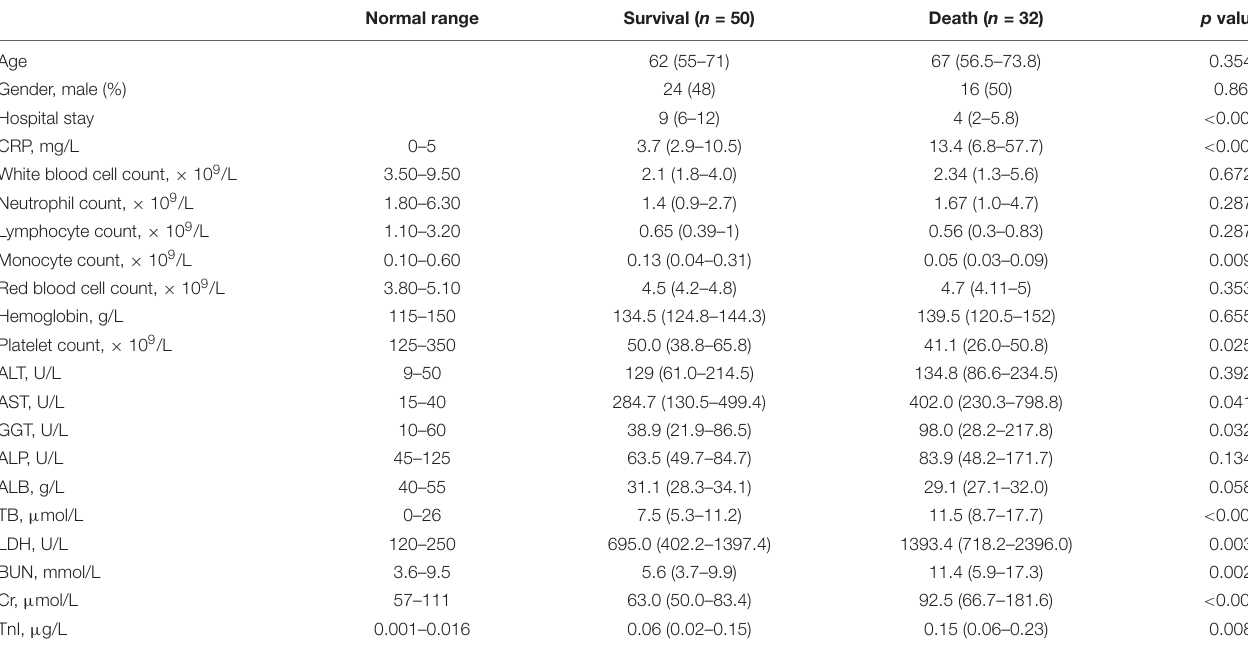
TABLE 1 | Baseline characteristics of patients between survival group and death